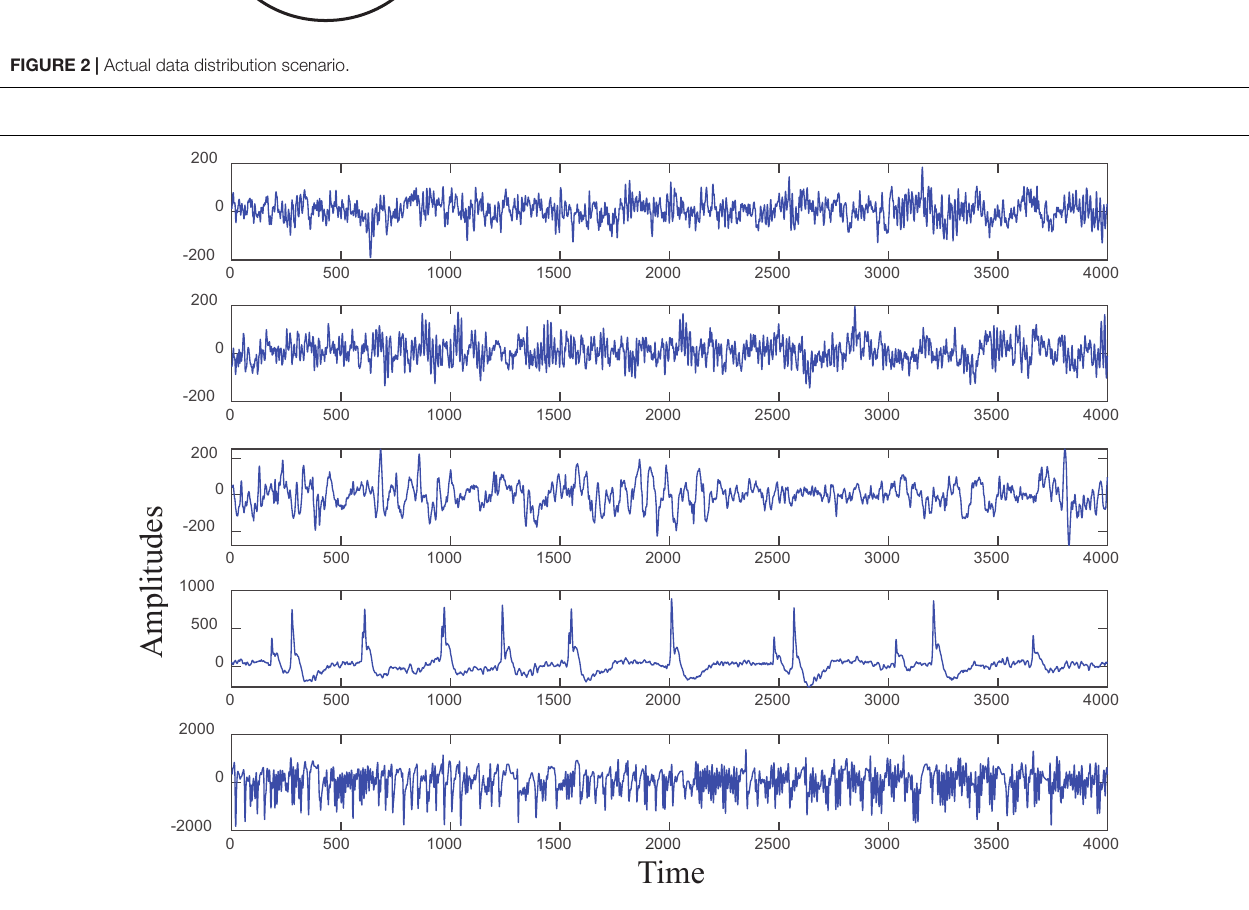
FIGURE 3 | Original epilepsy EEG